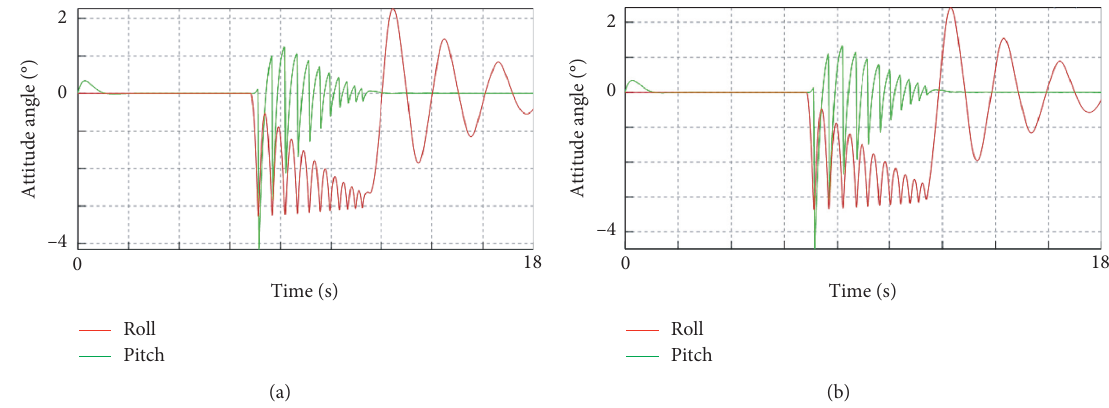
Figure 19: Changes of the attitude angle under different guide wheel treads: (a) 340mm and (b)